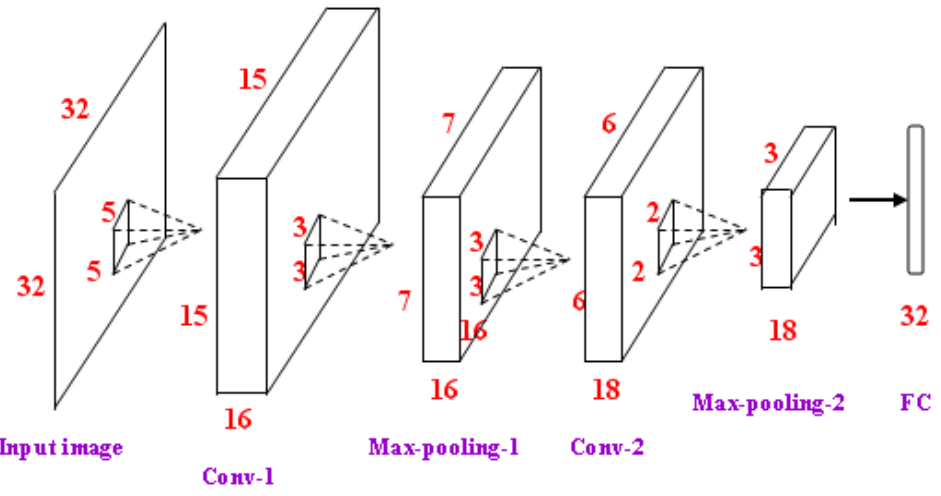
Figure 3. CNN networks for each face patch.